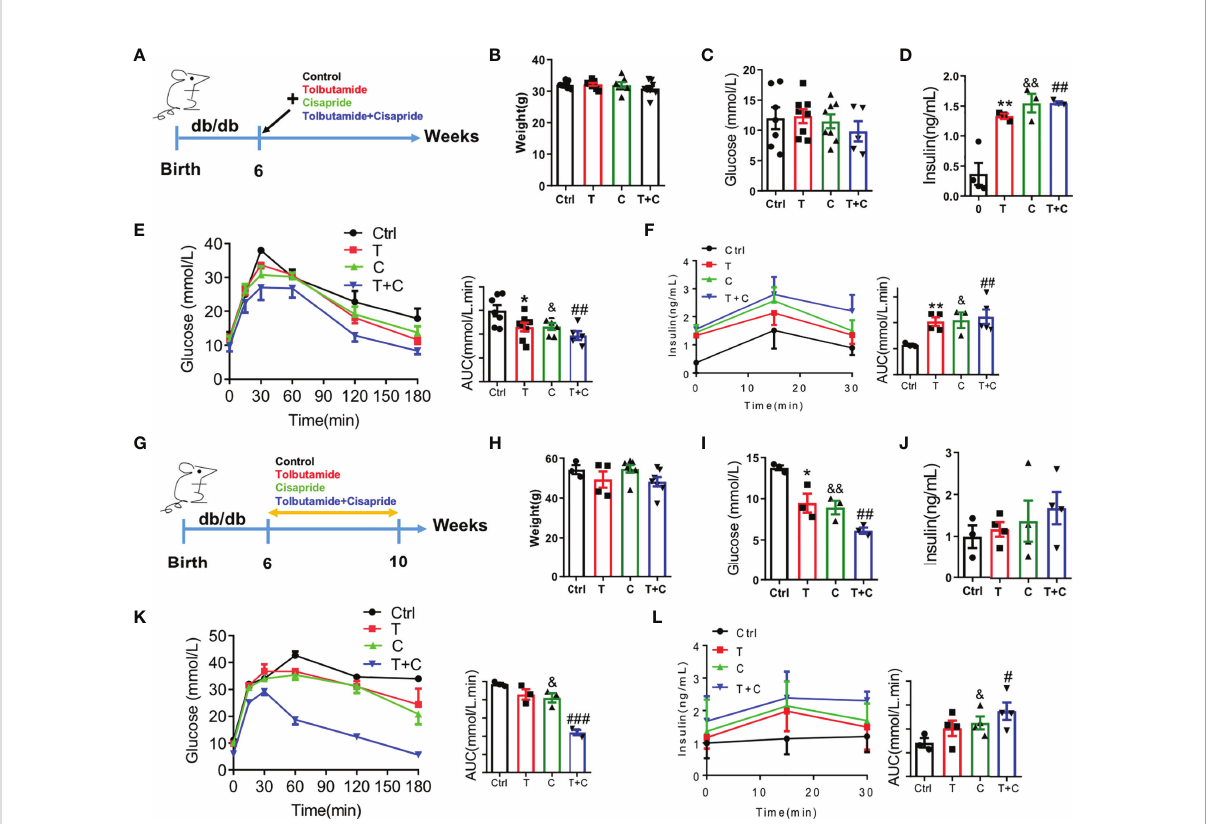
FIGURE 4 Cisapride regulated glucose metabolism in db/db mice (A) Six-week-old db/db mice were divided based on (B) body weight, (C) food intake, (D) fasting blood glucose and (E) fasting serum insulin. Different drugs were administered transiently to WT mice, including the control (physiolgical saline, Ctrl), tolbutamide (T, 20 mg/kg), cisapride (C, 20 mg/kg) and tolbutamide combined with cisapride (T+C). (F) Intraperitoneal glucose tolerance tests (IPGTTs) were performed in the 4 groups. (G) The abovementioned drugs were administered daily for 4 weeks to six- week-old db/db mice. (H) body weight, (I) food intake, (J) fasting blood glucose and (E) fasting serum insulin. (K) IPGTTs were performed. (L) IPIRT was performed. n=4 (B – F) or n=3 (G – L) for each group. * P < 0.05, ** P < 0.01, & P < 0.05, && P < 0.01, # P < 0.05, ## P < 0.01, ### P < 0.005 vs. Ctrl. Statistical comparisons were calculated using the Mann – Whitney U test (B-F, G – L)